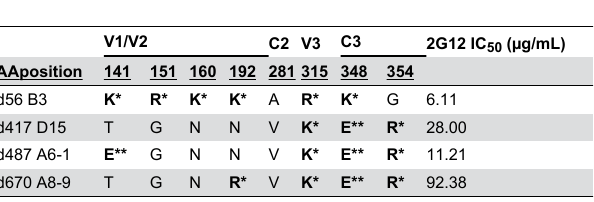
Regions of Envelope are noted in the top bar and below are the amino acid (AA) positions. Each row is an Env clone. * Positively and ** negatively charged amino